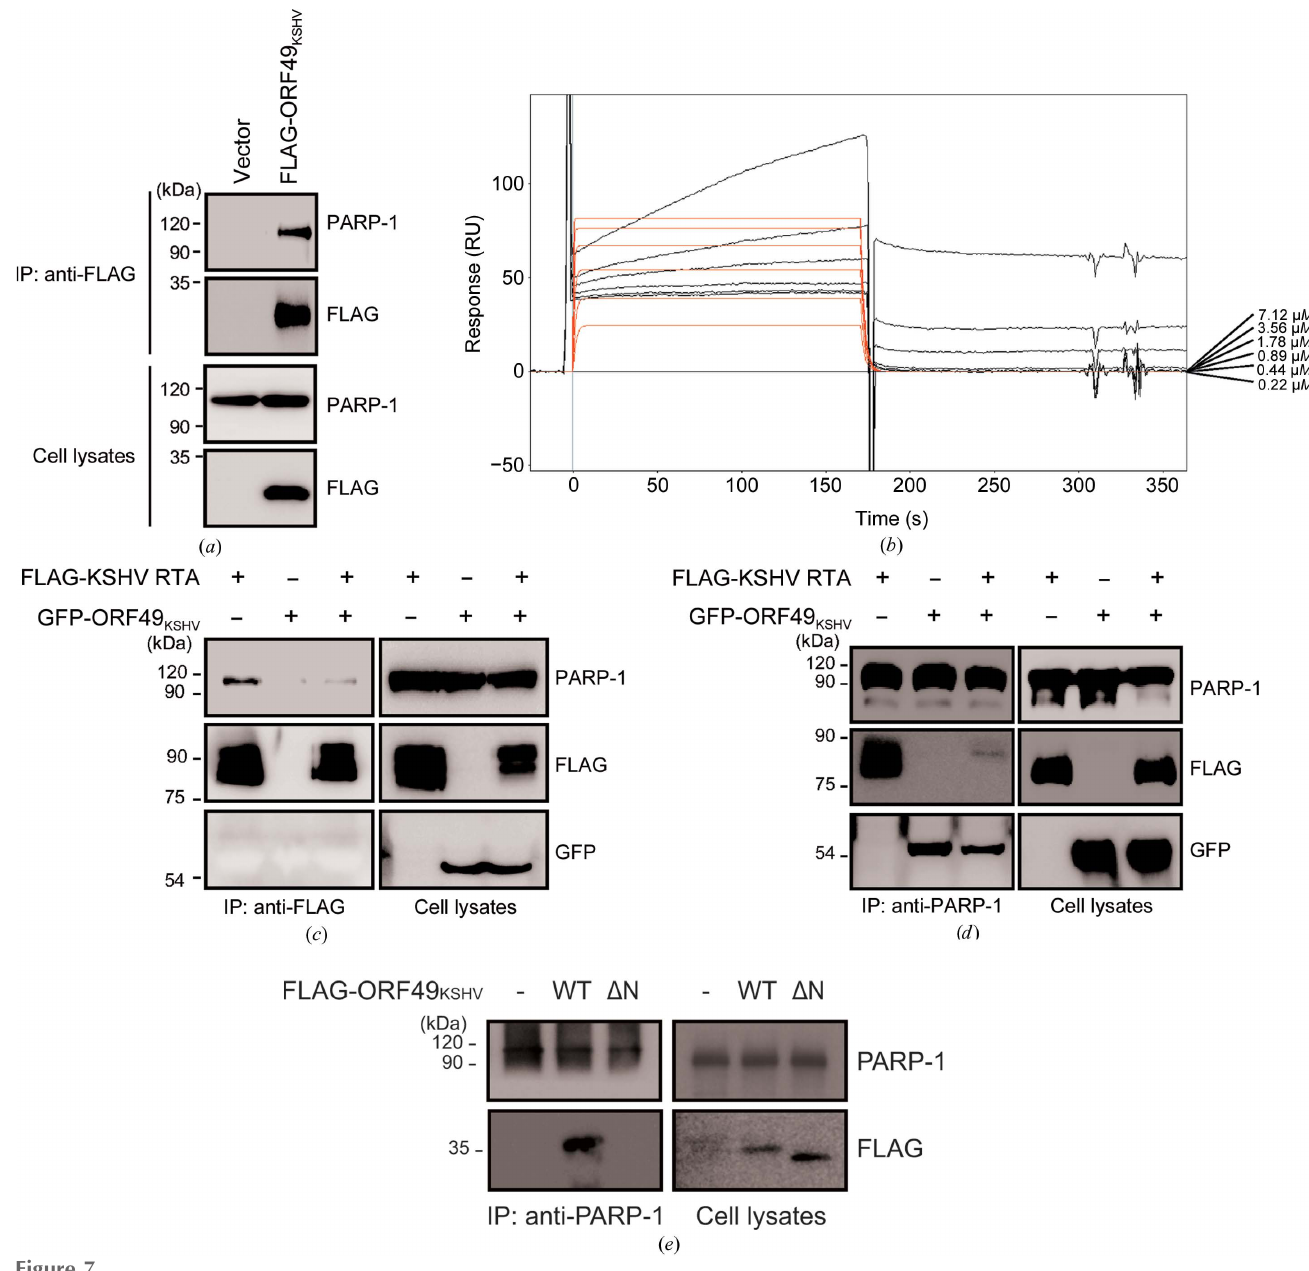
Figure 7 The conserved molecular mechanism of ORF49 KSHV interacting with PARP-1. ( a ) Interaction with PARP-1. FLAG-tagged ORF49 KSHV was transfected into HEK293T cells and incubated for 48 h. The cells were harvested and analyzed by co-IP assays with an anti-FLAG antibody. ( b ) SPR analysis of ORF49 KSHV with PARP-1. The ORF49 KSHV protein was injected at six concentrations (7.12, 3.56, 1.78, 0.89, 0.44 and 0.22 m M ). Dissociation data were collected for 120 s. The black lines show the actual data; the orange lines are curve fits. ( c , d ) Inhibition of interactions between RTA and PARP-1 by ORF49 KSHV . GFP-tagged ORF49 KSHV was co-transfected with FLAG-tagged RTA into HEK293T cells. The cells were harvested 48 h post-transfection and subjected to co-IP assays with an anti-FLAG antibody ( c ) or an anti-PARP-1 antibody ( d ). The results were analyzed by Western blotting. ( e ) PARP-1 interaction of the ORF49 KSHV mutant. FLAG-tagged ORF49 KSHV or ORF49 KSHV (cid:2) N was transfected into HEK293T cells. The cells were harvested 48 h post-transfection and assayed for PARP-1 interaction by co-IP assays with an anti-PARP-1 antibody. The results were analyzed by Western